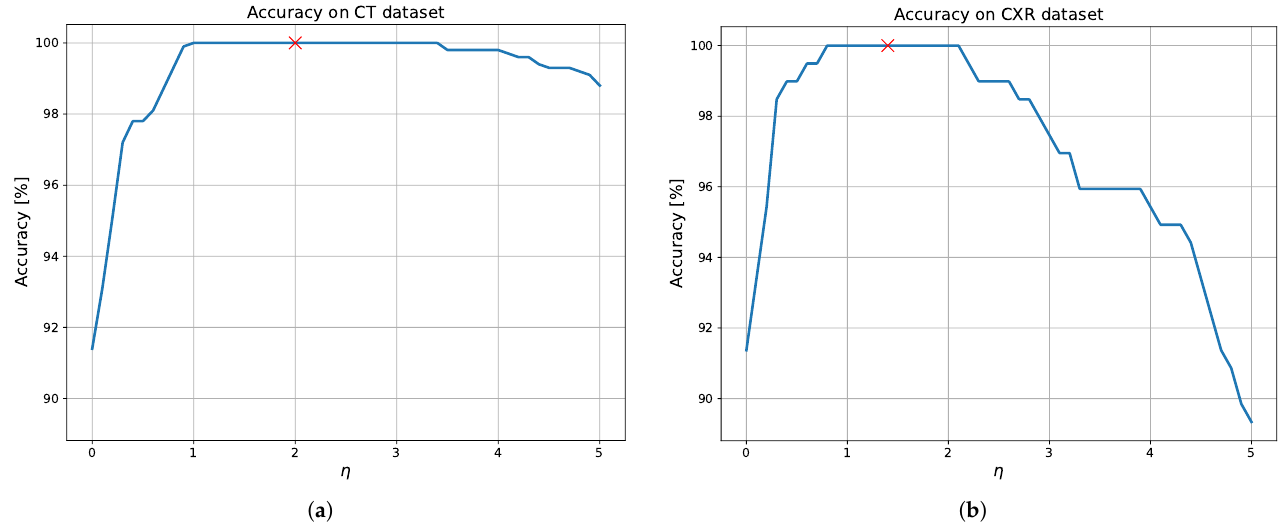
Figure 4. Accuracy (in %) as a function of the η parameter: ( a ) CT dataset and ( b ) CXR dataset. The best selected values ( η = 2 for CT dataset and η = 1.4 for CXR dataset) are shown with a red cross. The results have been evaluated by using the cosine distance, a number N T = 500 of target images, and a number N bin = 50 of histogram bins.